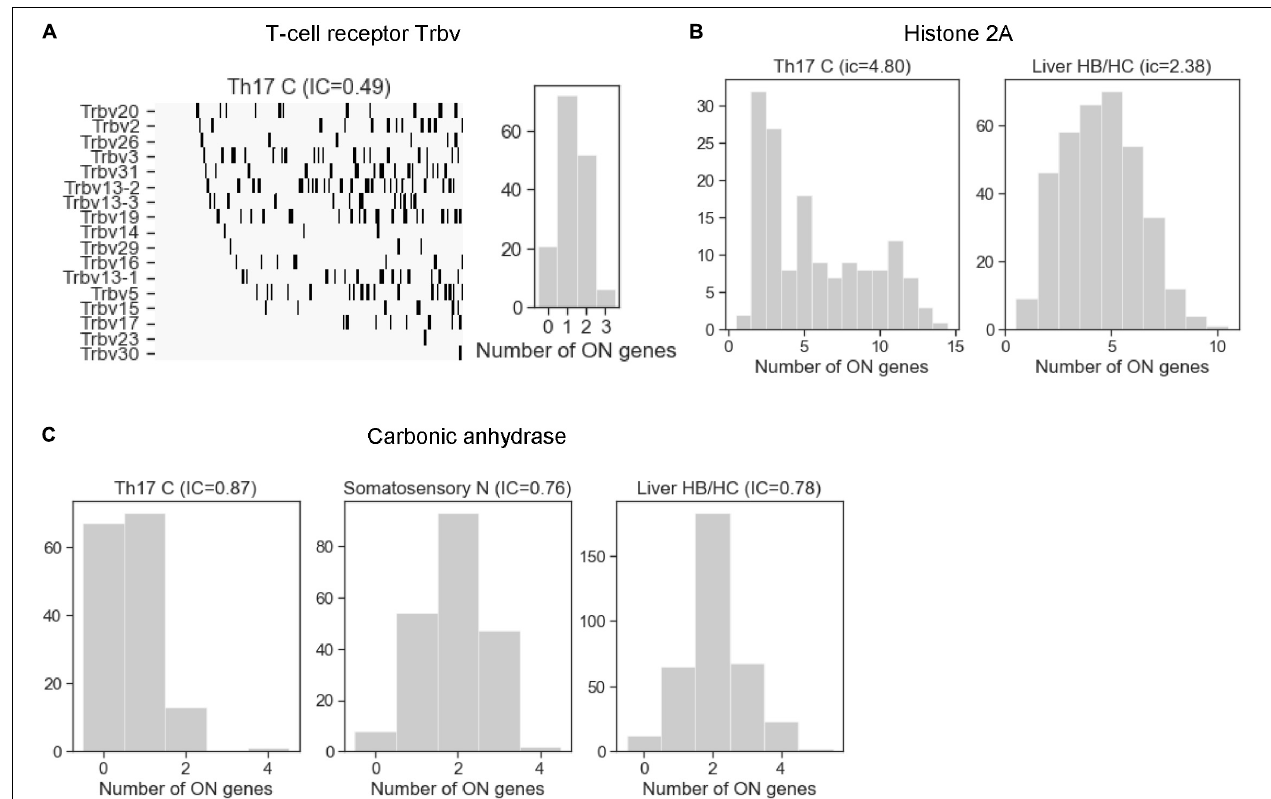
FIGURE 6 | The distribution of the number of expressed gene isoforms (ON genes) per cell in gene families with exclusive and concurrent expression. (A) The T-cell receptor beta chain family shows a clear exclusivity in Th17 cells ( IC = 0.49). The left plot shows the dichotomized expression states. Each column represents a single cell. The gene isoforms are ordered according to expression frequency (highest on the top) and the cells are ordered according to number of expressed isoforms per cell (lowest on the left side). (B) The histone 2A family shows co-occurrence in Th17 and liver HB/HC cells, with an IC value of 4.8 and 2.38, respectively. (C) The number of expressed carbonic anhydrase genes per cell in Th17 cells, somatosensory neurons, and liver HB/HC (IC = 0.87, 0.76 and 0.78,